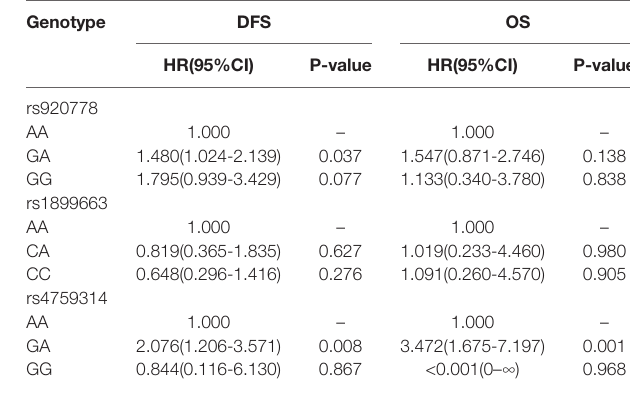
TABLE 8 | HR in different genotypes of HOTAIR SNPs in multivariate Cox regression analysis.